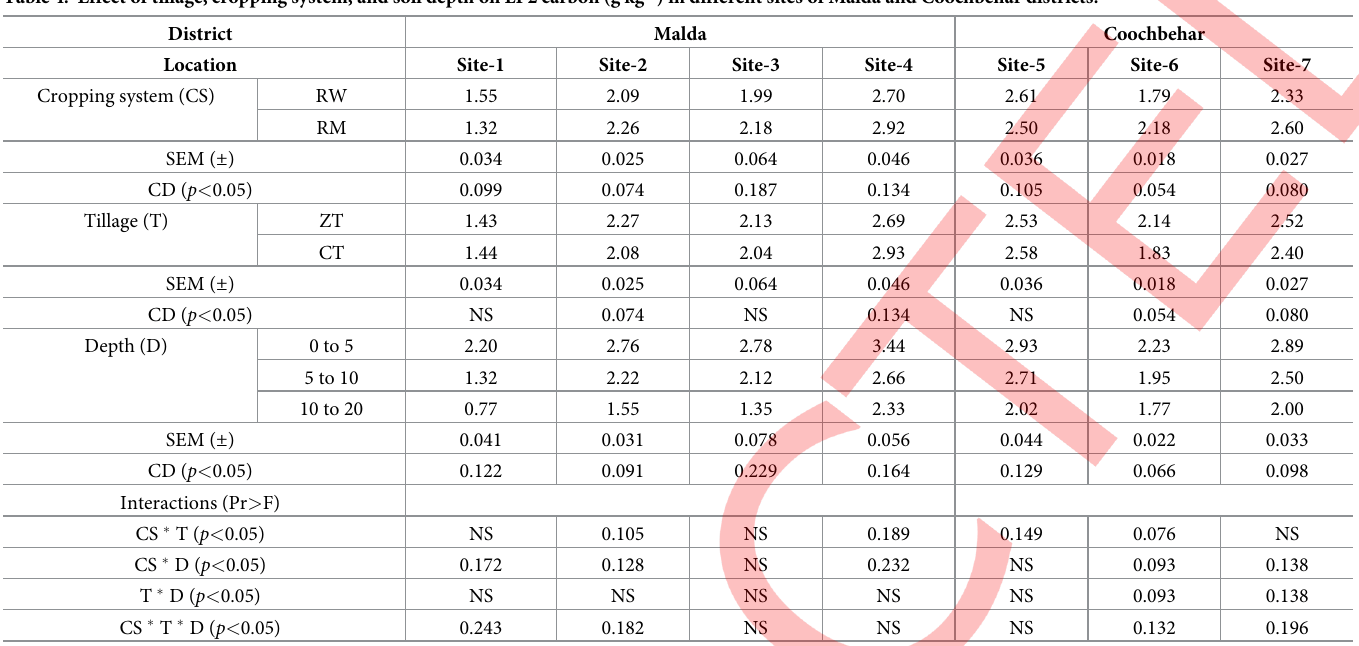
Table 4. Effect of tillage, cropping system, and soil depth on LP2 carbon (g kg -1 ) in different sites of Malda and Coochbehar districts. District Malda Coochbehar Location Site-1 Site-2 Site-3 Site-4 Site-5 Site-6 Site-7 Cropping system (CS)